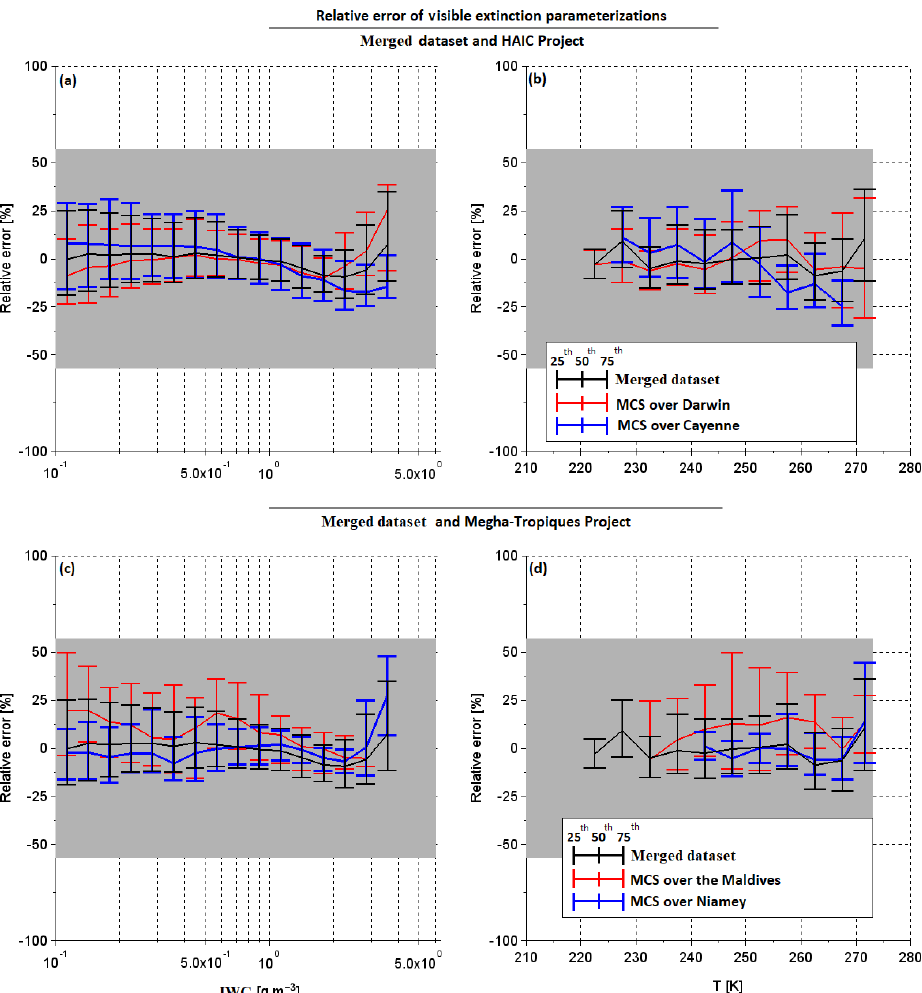
Figure 20. Relative errors of predicted visible extinction, Eq. (8), with respect to measured visible extinction for (a–d) . Relative errors as a function of IWC in (a) and (c) and as a function of T in (b) and (d) . The black lines in the four panels represent the relative errors when calculated for the merged dataset. In (a) and (b) , the red lines show the median relative error for MCS over Darwin and the blue line shows the same for MCS over Cayenne. In (c) and (d) , the red line represents the median relative error for MCS over the Maldives and the blue lines show the same for MCS over Niamey. The bottom of the error bar shows the 25th percentile of relative error, and the 75th percentile are given by the top of the error